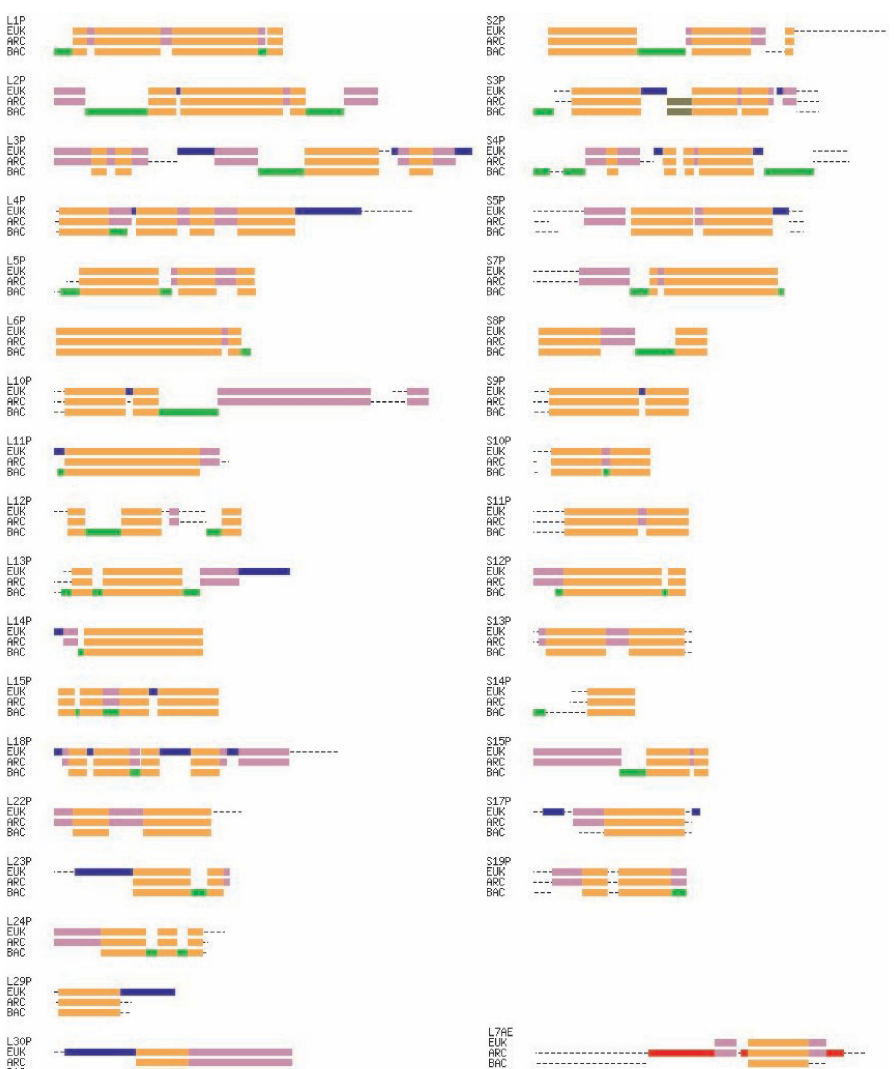
Figure 3. A schematic repre- sentation of the multiple align- ments of the 34 universal ribosomal proteins common to Eukarya, Archaea and Bacte- ria. Orange marks segments alignable, and thus homolo- gous, across all three phylo- genetic domains; purple marks blocks alignable across Eukarya and Archaea; blue marks those blocks alignable only with in the Eukarya; red marks those blocks alignable only within the Archaea; dark green marks blocks alignable only across Archaea and Bac- teria, while light green marks those alignable only within the Bacteria. The dotted lines rep- resent sequence regions of varying length unalignable across the full sets of any of the three groups. The represen- tative species are listed in the legend of Figure 4. Ribosomal protein L7ae has been identi- fied in some, but not all, major representative